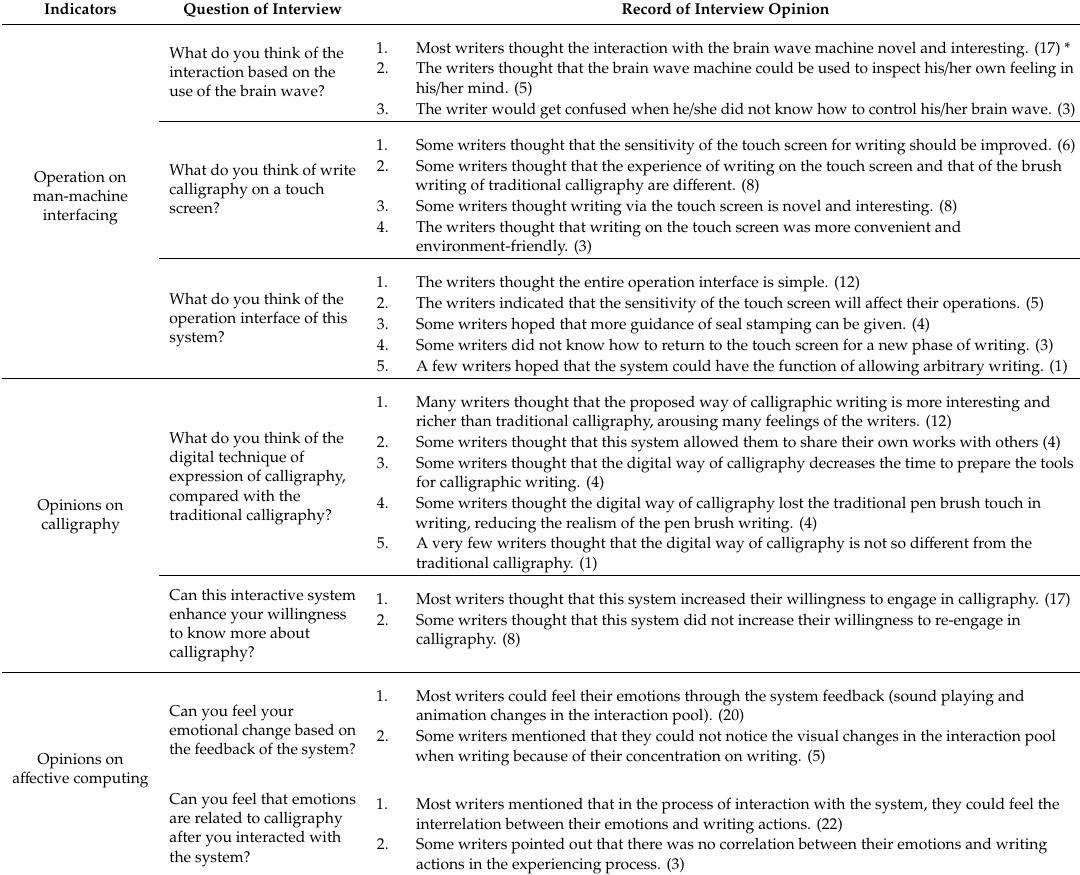
Table 9. Interview results obtained from the writers participating in the first